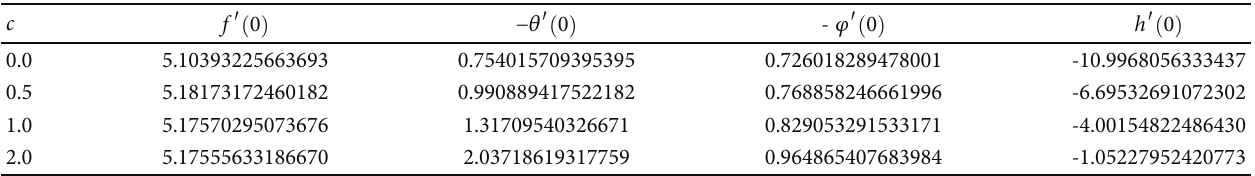
Table 6: Values of skin friction coe ffi cient, heat transfer and mass transfer for suction variation with γ = 45 ° , M = 2, Pr = 0 : 71, Sc = 0 : 22,